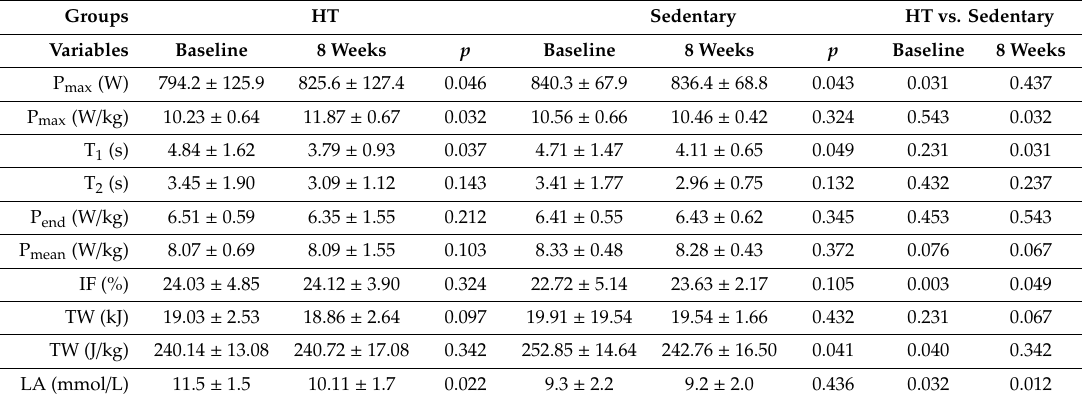
Table 2. Wingate test parameters at baseline and after 8-weeks of